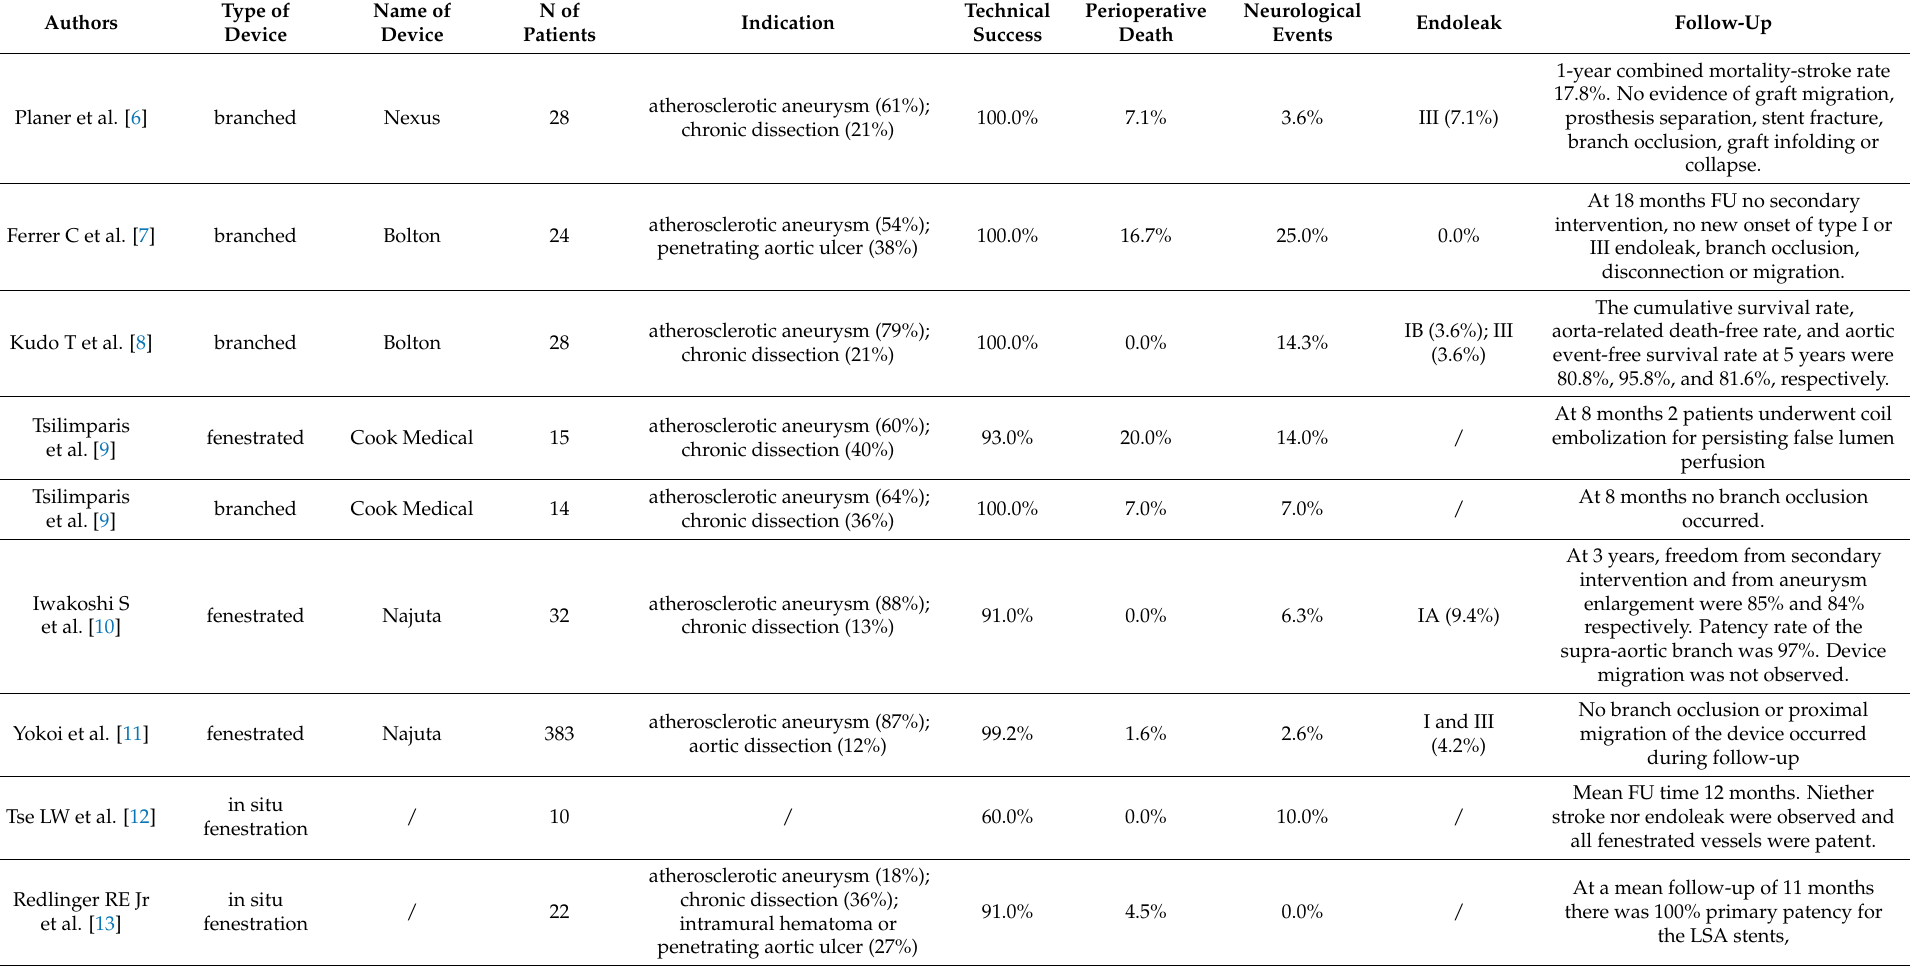
Table 1. Results of the main studies published about aortic arch stent grafting with the different techniques described in this